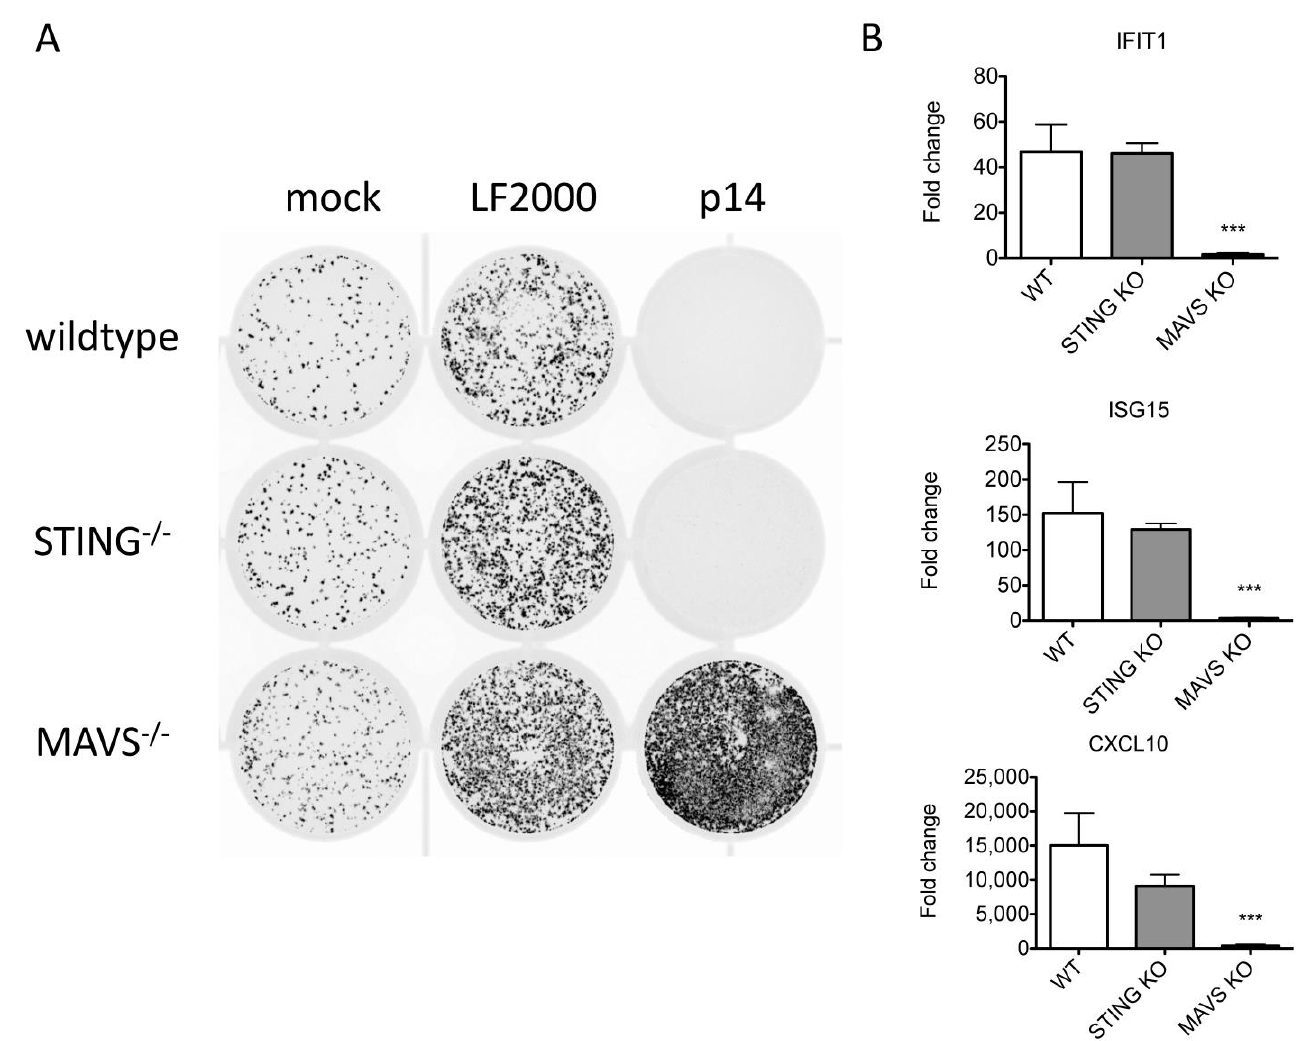
Figure 2. The antiviral response to p14 lipoplexes depends on MAVS but not STING. Wildtype (WT), STING -/- , or MAVS -/- THF cells were treated with p14 lipoplexes, Lipofectamine 2000 or media alone and ( A ) challenged with VSV-GFP in a plaque reduction assay 16 h later or ( B ) cellular RNA was harvested 12 h later for analysis. Levels of IFIT1, ISG15 and CXCL10 transcripts were measured using quantitative RT-PCR and shown relative to mock-treated THF cells. Group means were log-transformed and compared to that of wildtype (WT) by one-way ANOVA with Bonferroni post-tests (*** for p < 0.001).